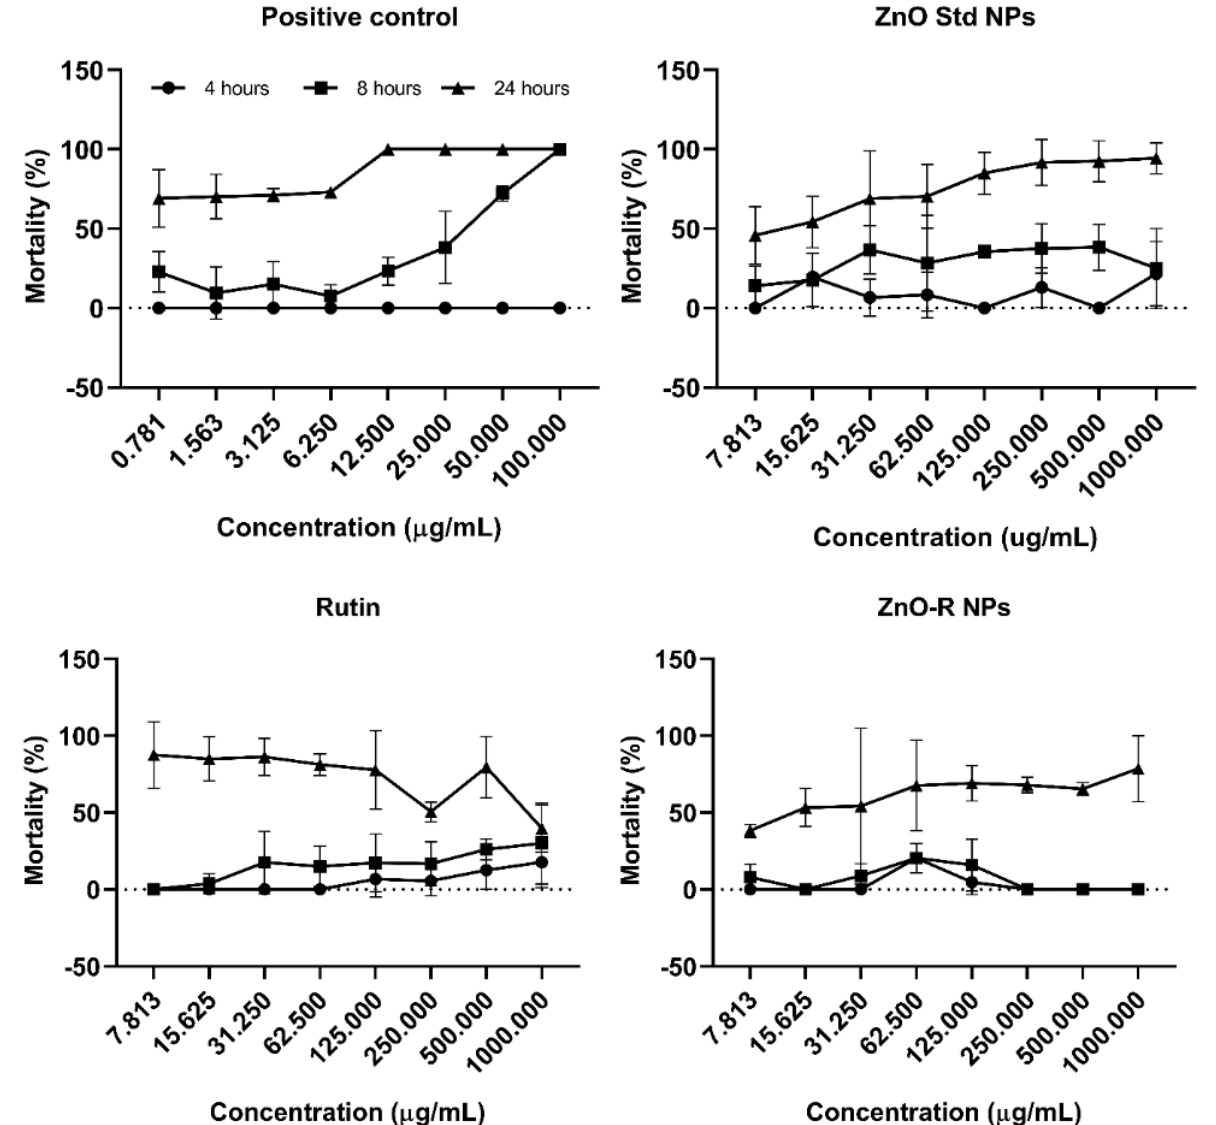
Figure 9. Mortality rates of Artemia nauplii at different concentrations of NPs and rutin. Figure 10 shows the aggregation of ZnO NPs inside the gut of Artemia nauplii. The filter-feeding behaviour of Artemia is nonselective; they consume any particle smaller than 50 µ m. The amount consumed by each individual animal at varying concentrations has an impact on the aggregation level. As illustrated in Figure 10, the guts of the animals in the control group were empty (no signs of aggregation; the mouthparts and gut region appeared transparent), but the guts of the animals in the treatment group were completely full of NPs. The images also verified that Artemia nauplii were able to eliminate the ingested NPs. Moreover, no significant change in the size of Artemia nauplii was observed compared with that of the negative control. Regarding the positive control, their size was significantly smaller at concentrations higher than 25 µ g/mL ( p <